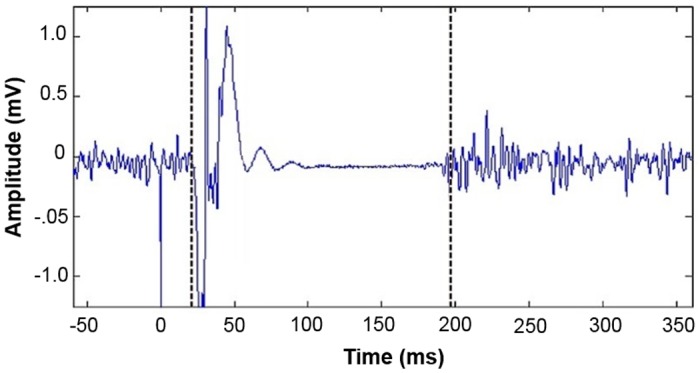
Example window—found CSP onset and offset of a single trial are depicted.mV = millivolt, ms = milliseconds.